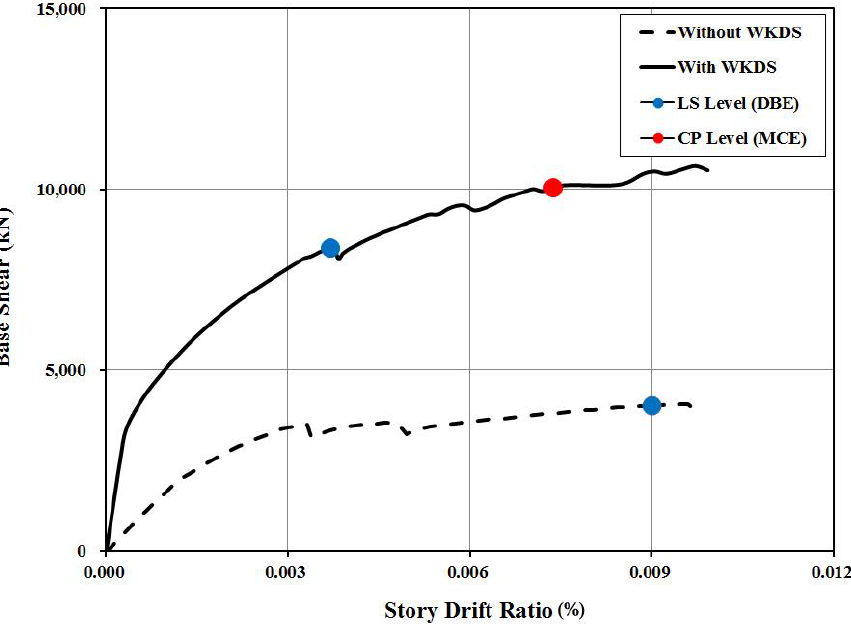
Figure 22. Pushover curves of the unreinforced and the retrofitted building structures with